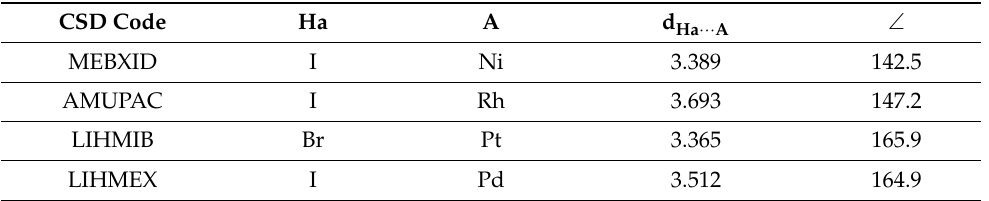
Table 8. CSD codes, HaB donor (Ha) and acceptor (A) atoms, intermolecular distance (d Ha ··· A in Å), and X–HaB ··· A (X = N, O, and S) angle ( ∠ in ◦ ). CSD Code